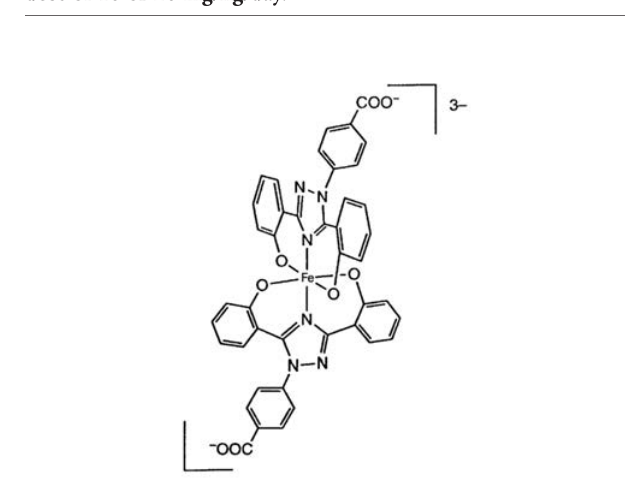
Figure 7. Mean plasma concentrations of deferasirox following a dose of 10 or 20 mg/kg/day.